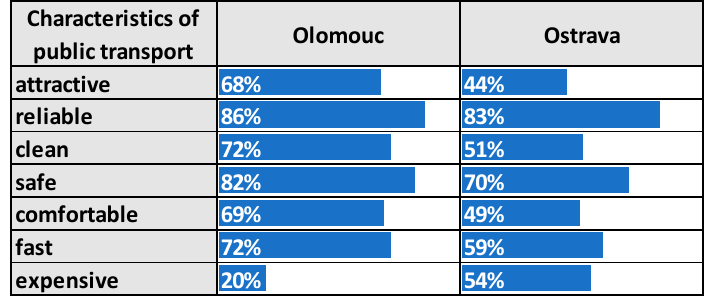
Figure 11. Evaluation of different perceptions of selected characteristics of public transport in Olomouc and Ostrava (grey band shows the percentage).